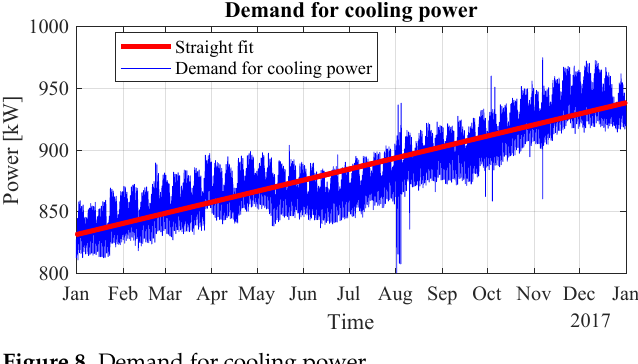
Figure 8. Demand for cooling